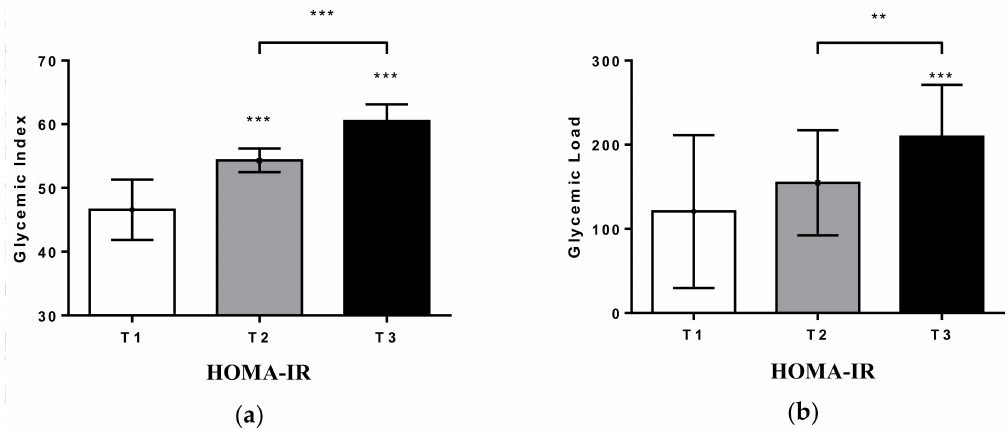
Figure 2. ( a ) Description of GI according to tertiles of HOMA-IR. ( b ) Description of GL according to tertiles of HOMA-IR. Significance is considered ** p < 0.01, *** p <